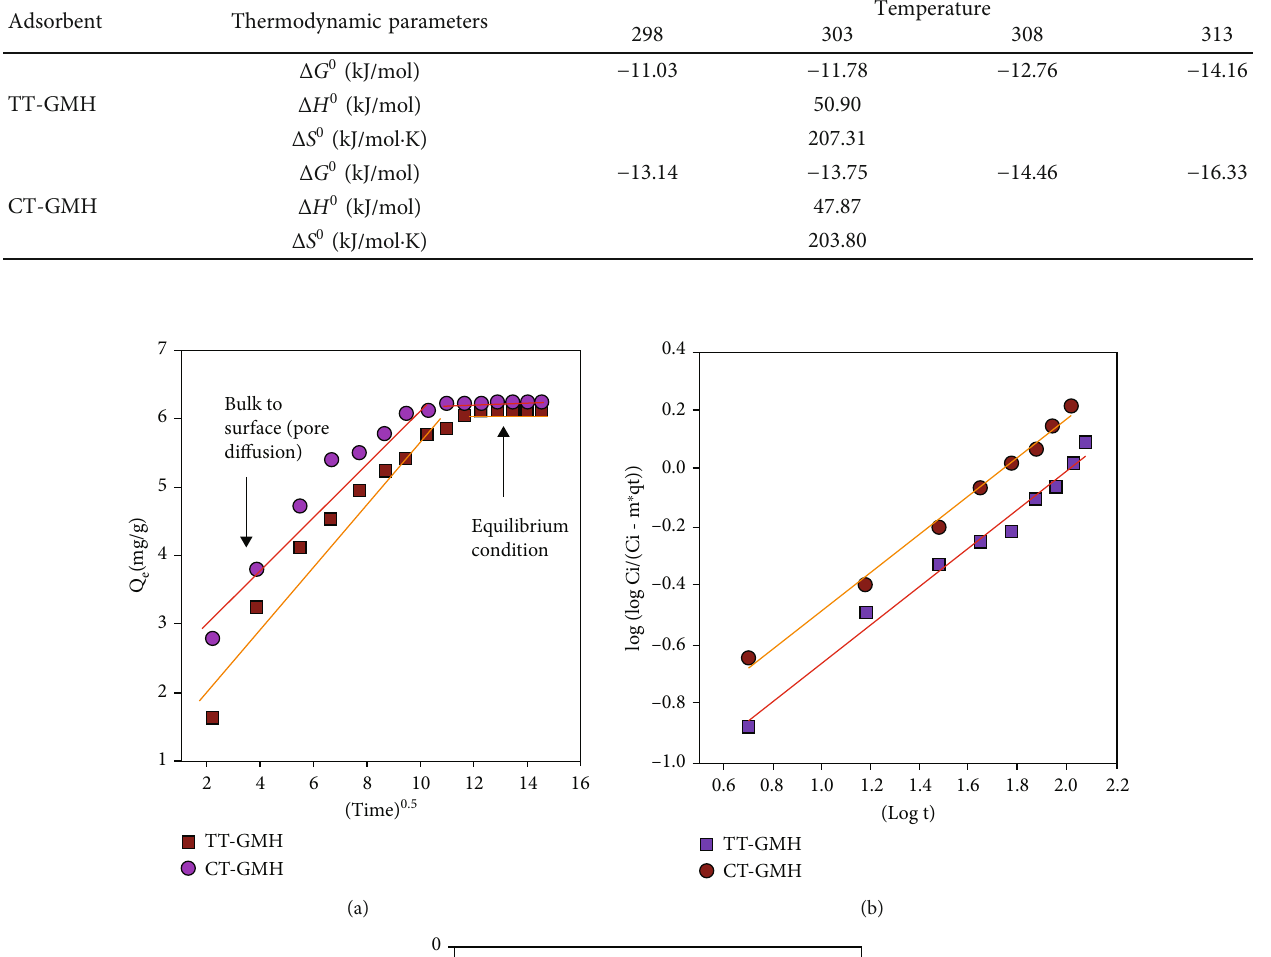
Table 4: Thermodynamic parameters at di ff erent temperatures for adsorption of Cr(VI) on TT-GMH and CT-GMH.